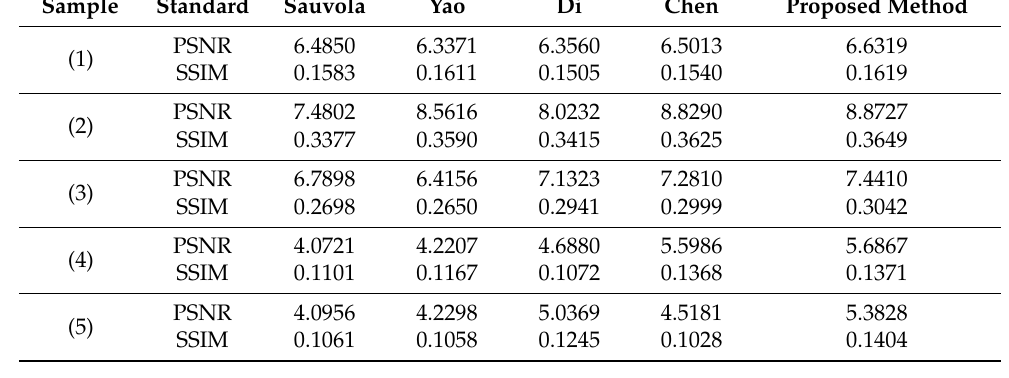
Table 4. The values of PSNR and SSIM of different QR codes after using different algorithms.